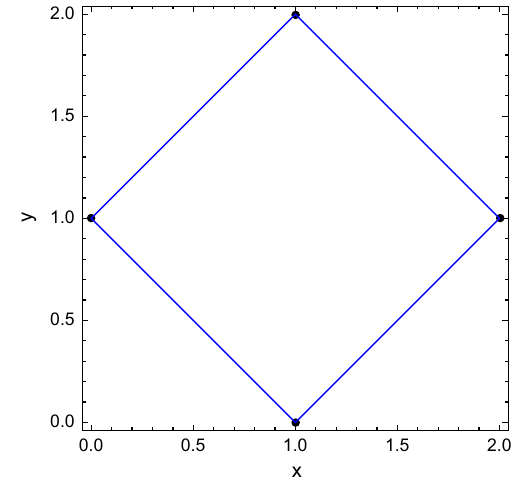
. Now for a nor- j